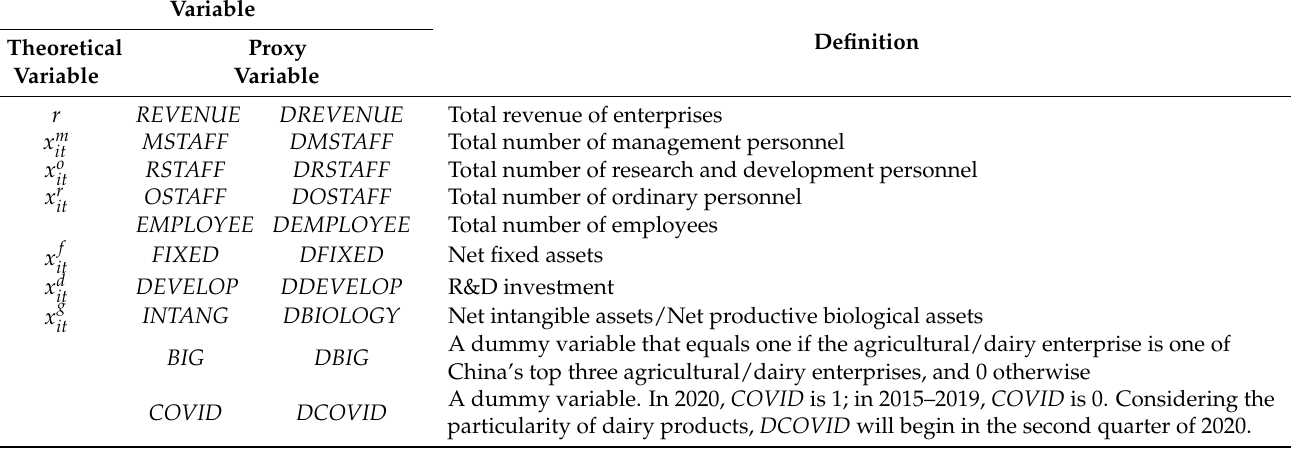
Table 1. Variable